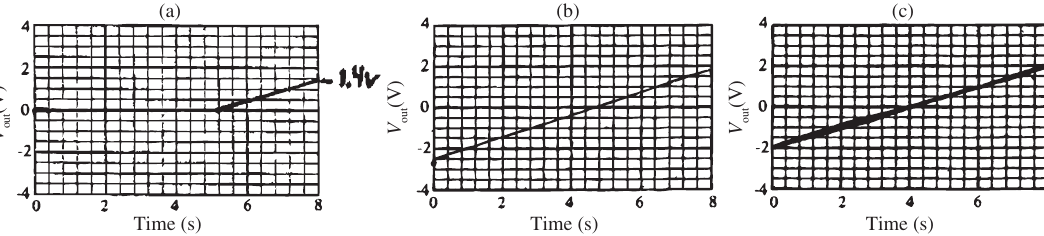
FIG. 6. Common student responses to the follower graphing task (shown in Fig. 5). These responses shown include the following: (a) a quantitatively correct graph, (b) a linear graph with an offset of – 0.6 V, and (c) a linear graph with no